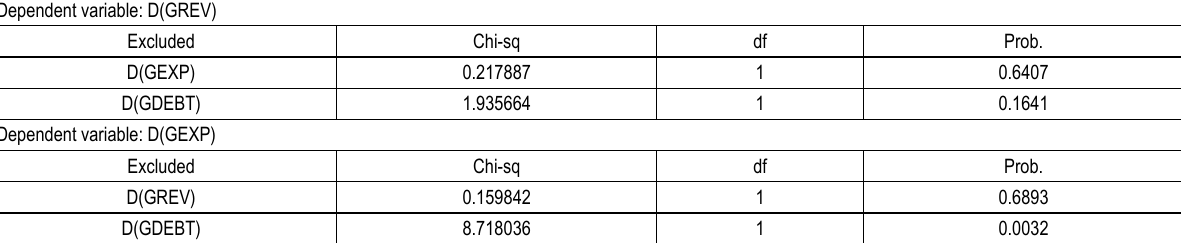
Table 9. Causality test (VEC Granger causality)